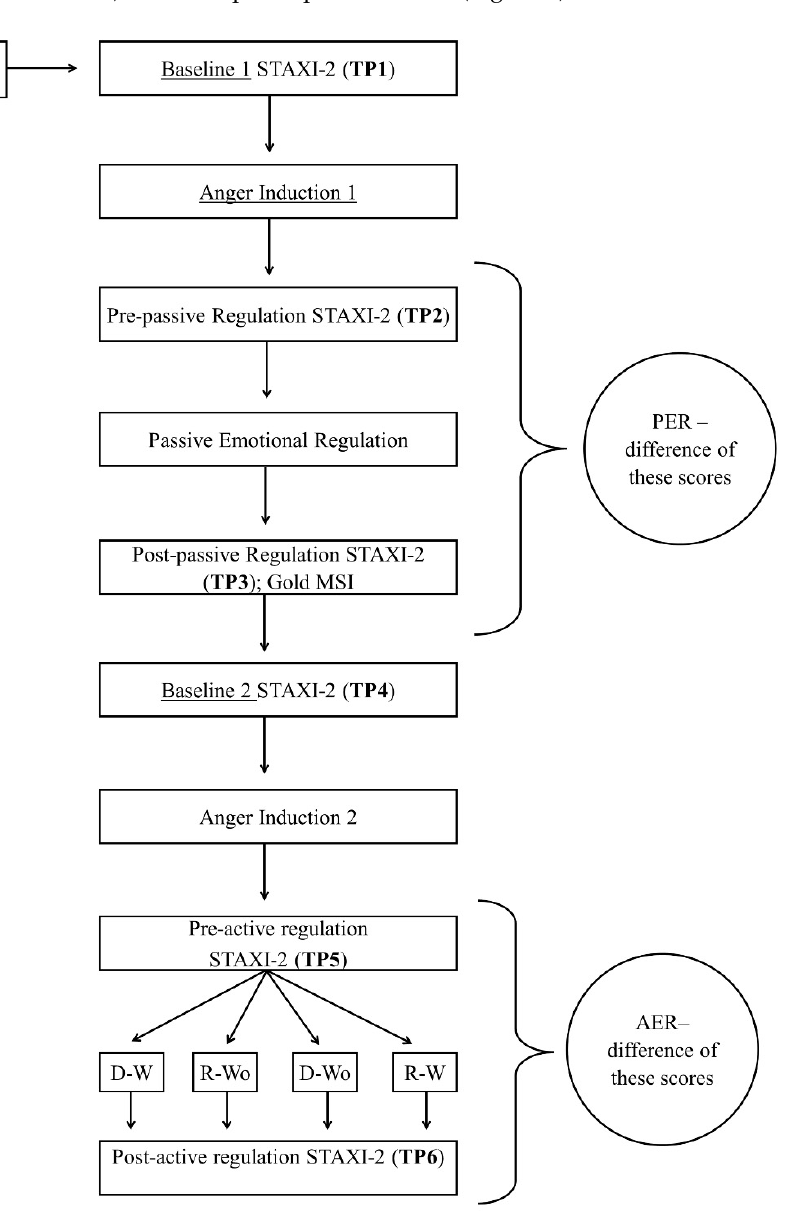
Figure 1. Experimental sequence (EF = Executive Functions; TP = Time Point; PER = Passive Emotional Regulation; AER = Active Emotional Regulation; D–W = distraction with music; D–Wo = distraction without music; R–W = reappraisal with music; R-Wo = reappraisal without music).